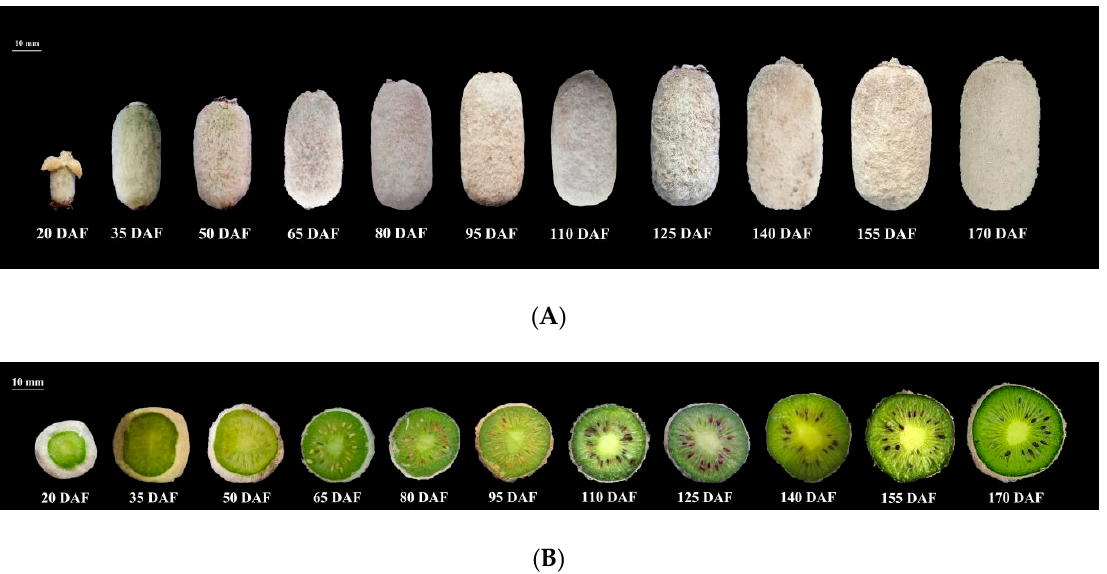
Figure 6. Fruits of A. eriantha ‘Ganmi 6’ at different developmental periods. ( A ) fruits; ( B ) cross sections. DAF: Days After Flowering.